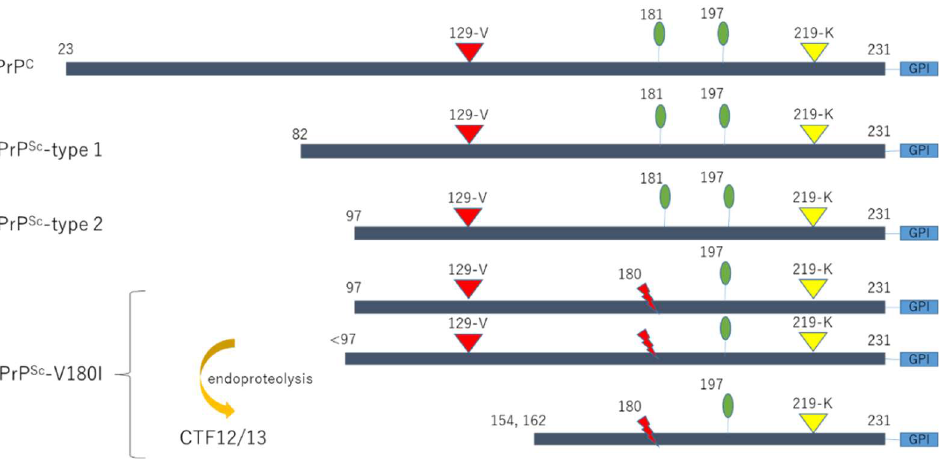
Figure 3. Diagram of the pathogenic PrP fragments. Two glycosylated sites are represented as green ellipses. Major PrP Sc fragments (types 1 and 2) are shown, along with the two components of the PrP Sc -V180I fragments. The polymorphisms in the prion gene are represented as inverted triangles; additionally, red (129-V) and yellow (219-K) inverted triangles show exacerbating and protective effects, respectively, on PrP Sc -V180I toxicity [51]. This Figure was modified and cited from reference 24 and 26. PrP, prion proteins; PrP C , normal prion proteins; PrP Sc , abnormal prion proteins; PrP res , protease-resistant abnormal prion proteins; V180I, valine to isoleucine substitution at codon 180; 129-V, valine polymorphism at codon 129; 219-K, lysine polymorphism at codon 219.